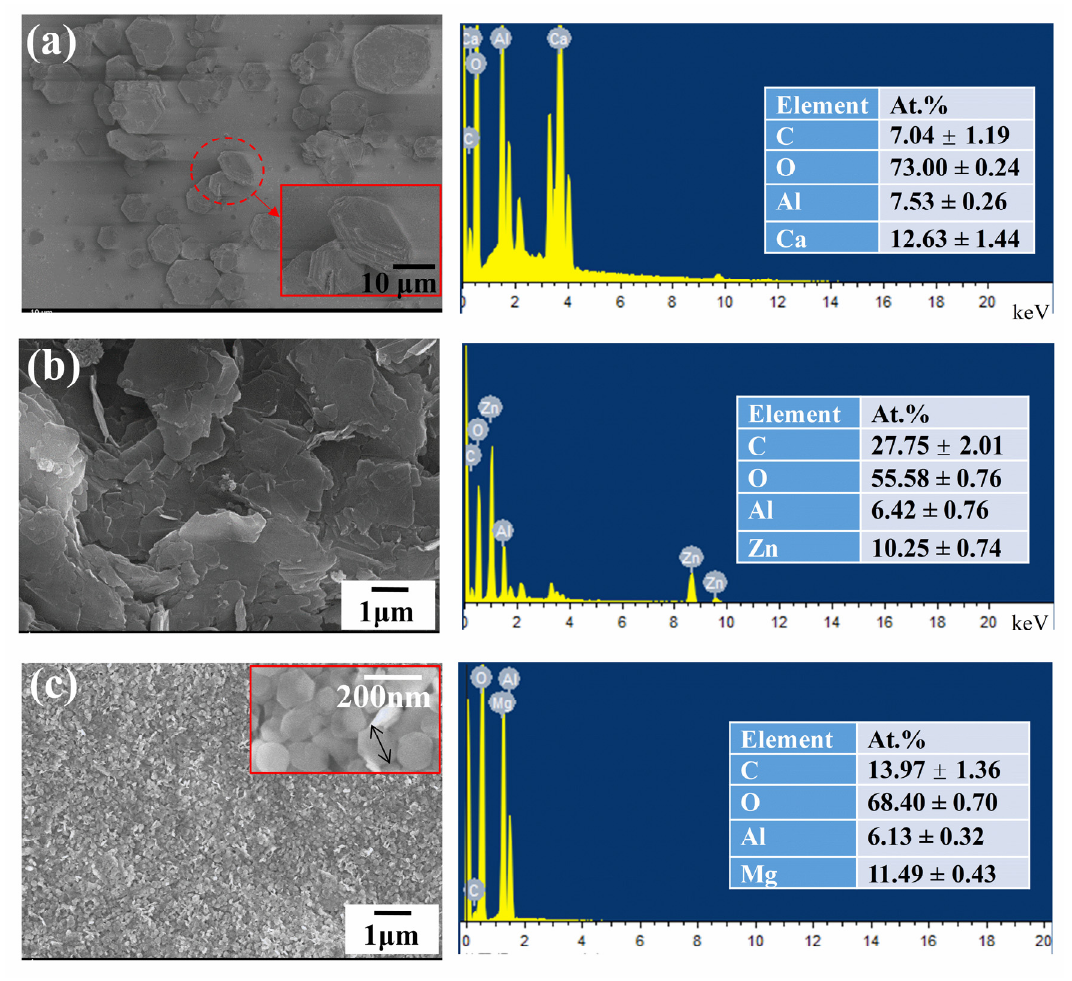
Figure 1. The SEM and corresponding EDS results of ( a ) Ca2Al1-LDH, ( b ) Zn2Al1-LDH, ( c )